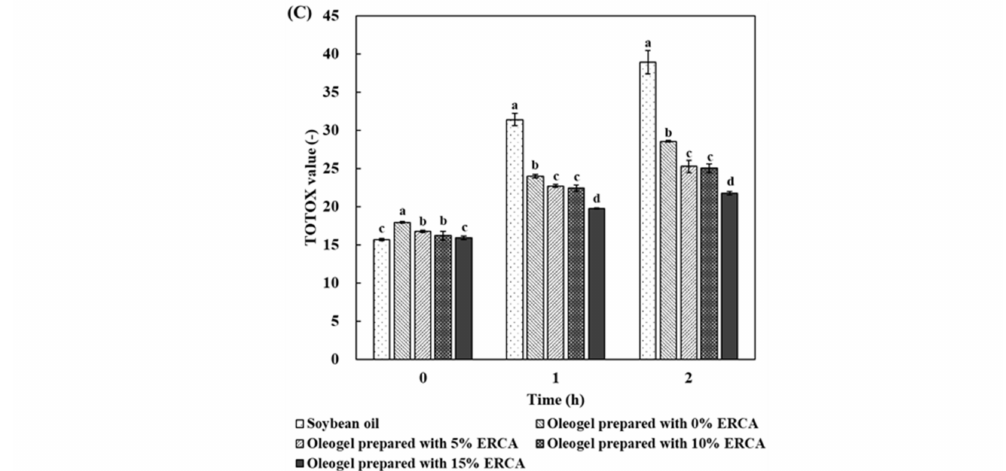
Figure 7. Changes in peroxide value ( A ), p -Anisidine value ( B ), and TOTOX value ( C ) of soybean oil and oleogels prepared with different concentrations of esterified rice flour with citric acid (ERCA; 0, 5, 10, and 15%, respectively) during heating at 140 ◦ C for 0, 1, and 2 h. Bars with different letters within the same bar differ significantly ( p < 0.05).